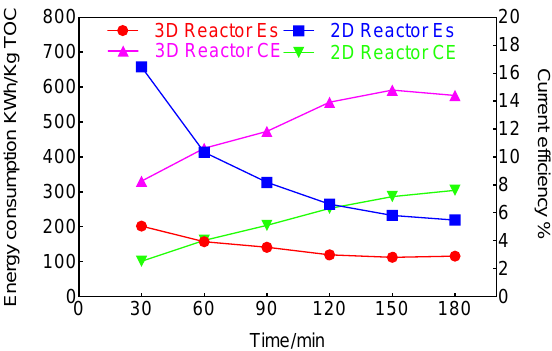
Figure 5. Energy consumption (Es) and current efficiency (CE) of the recycling-flow 3D and 2D electro-reactor systems (RhB wastewater initial concentration is 100 mg/L; volume is 500 mL; initial pH is 7, Na 2 SO 4 as an electrolyte, initial concentration is 2 g/L; voltage is 5 V; HRT is 20 min; current density is 60 mA/cm 2 ).